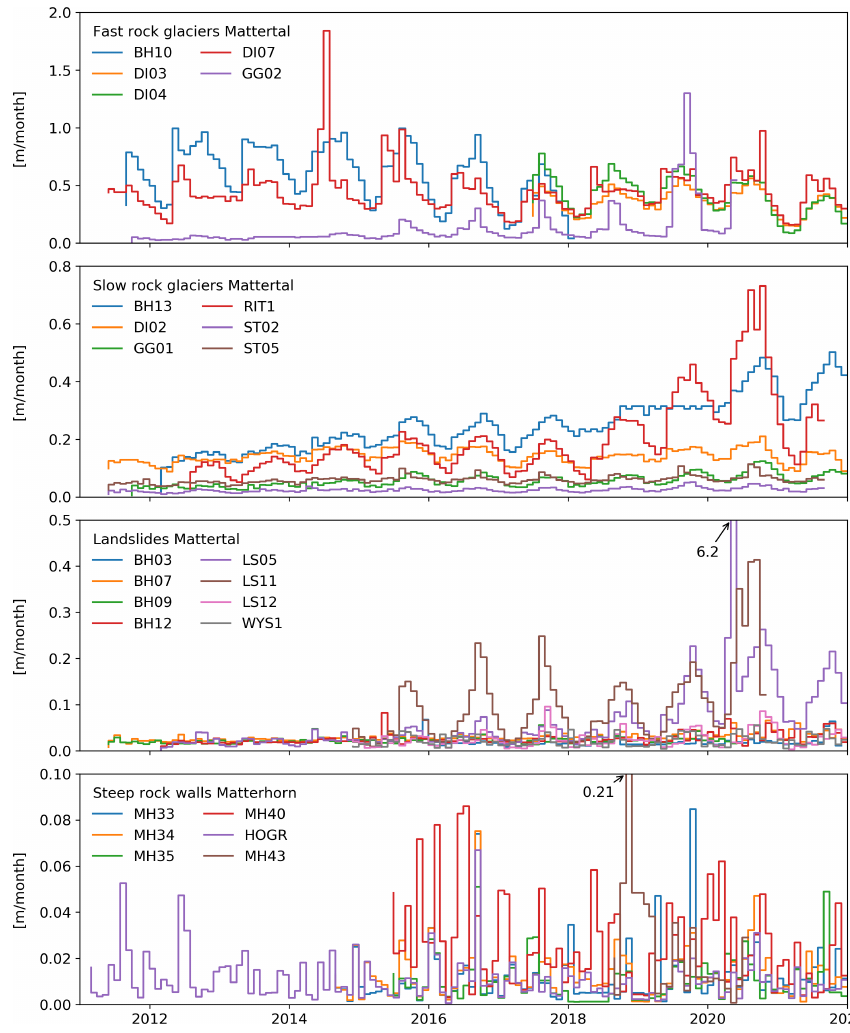
Figure 7. Time series of all GNSS positions presented in this paper, classified by landform type and range of displacement rates. The outlier in the Landslides Mattertal (LS05, Summer 2020) was due to a superficial roto-translatory movement of the boulder on which the sensor was placed, as confirmed by a 24 ◦ rotation visible in the inclinometer